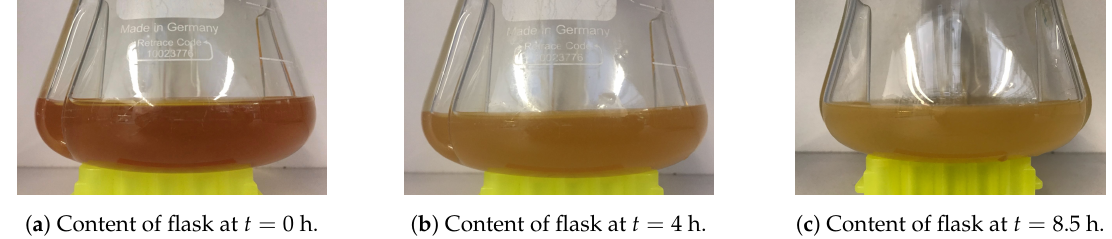
Figure 1. Colour change of medium during cultivation of yeast in shake